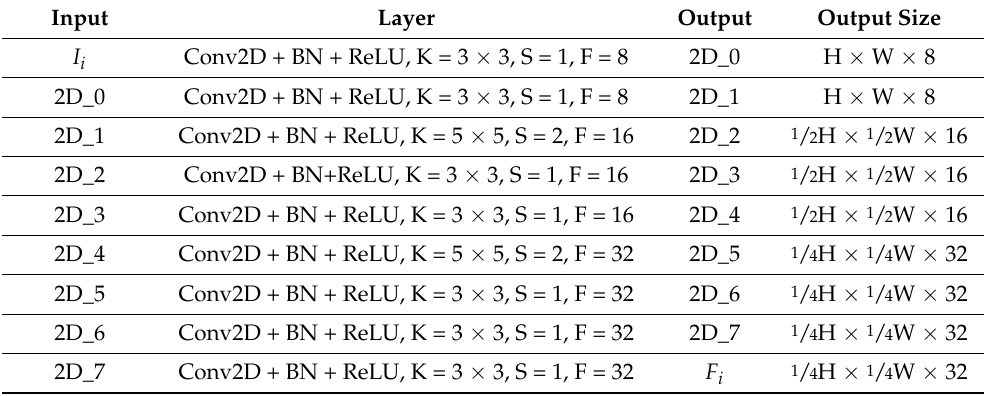
Table 1. Detailed architecture of the feature extraction